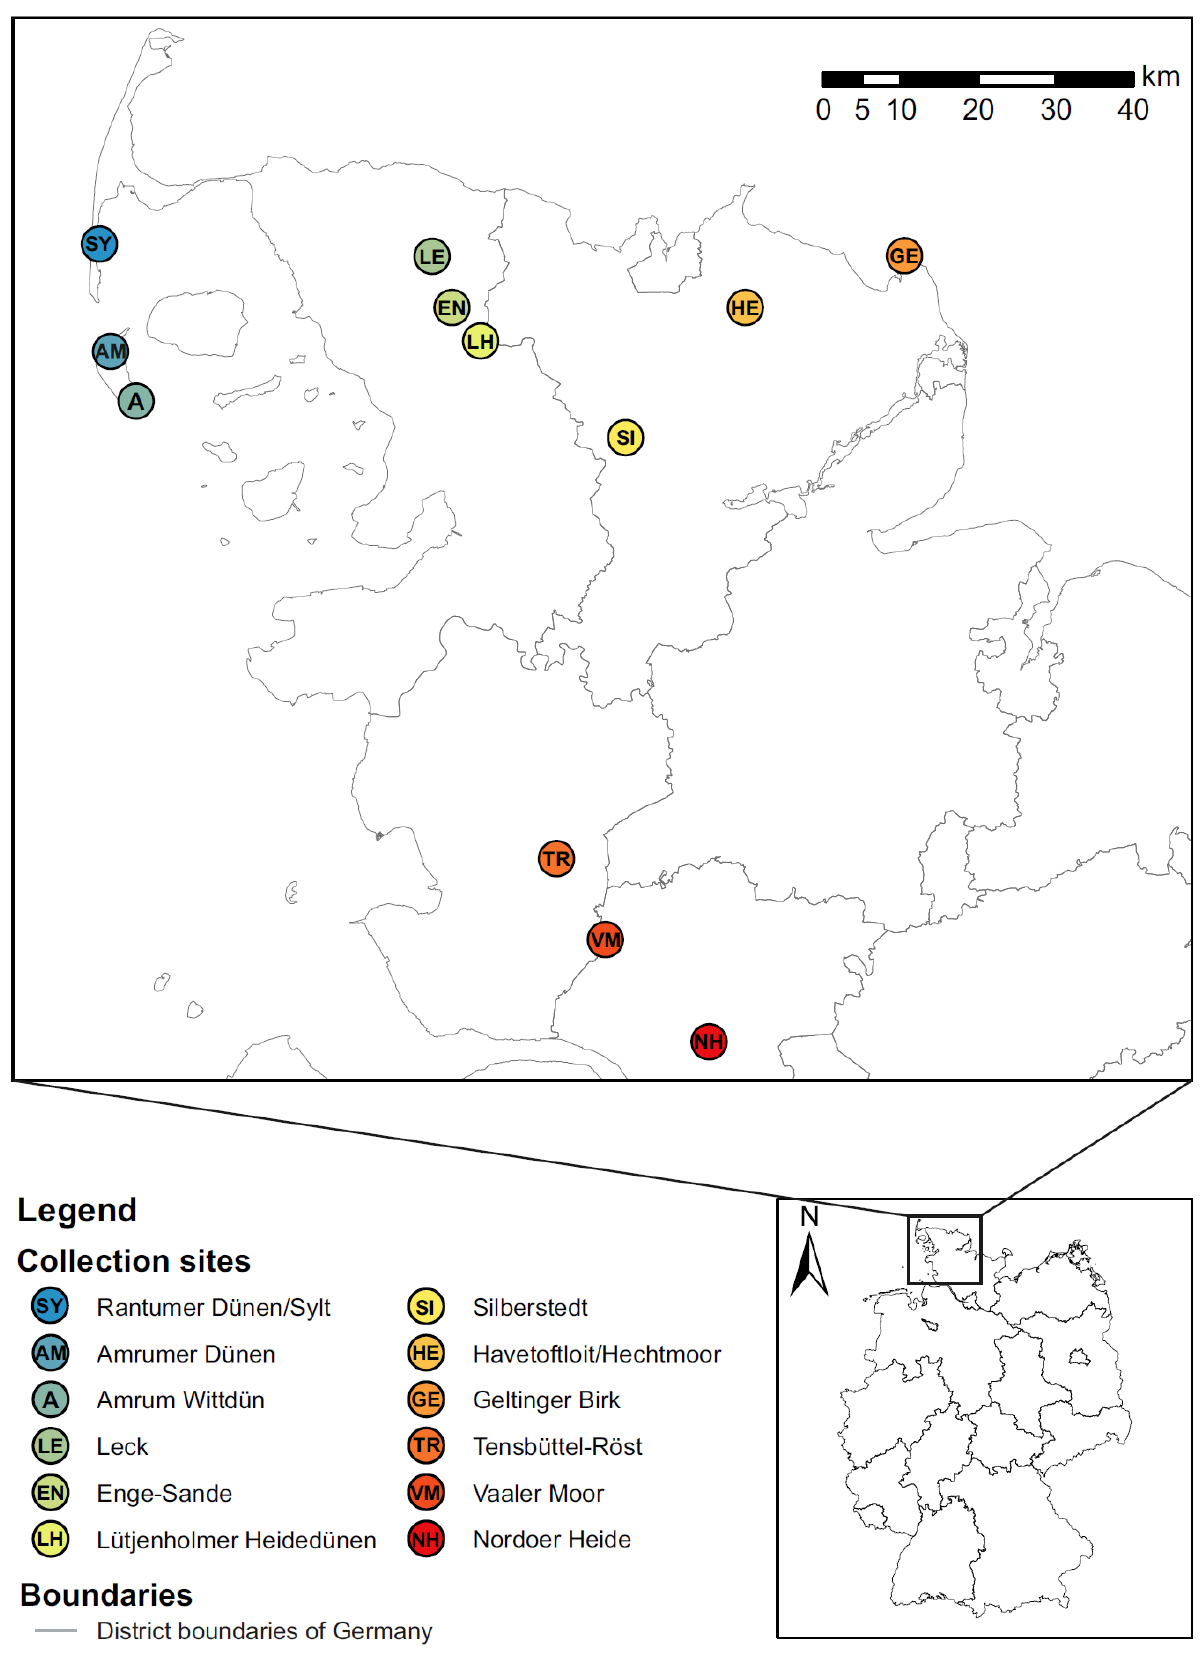
Figure 1. Map and collection sites of the study region in Schleswig-Holstein, Germany. Map was prepared with ArcGIS Desktop (ArcGIS Desktop 10.2.2.,